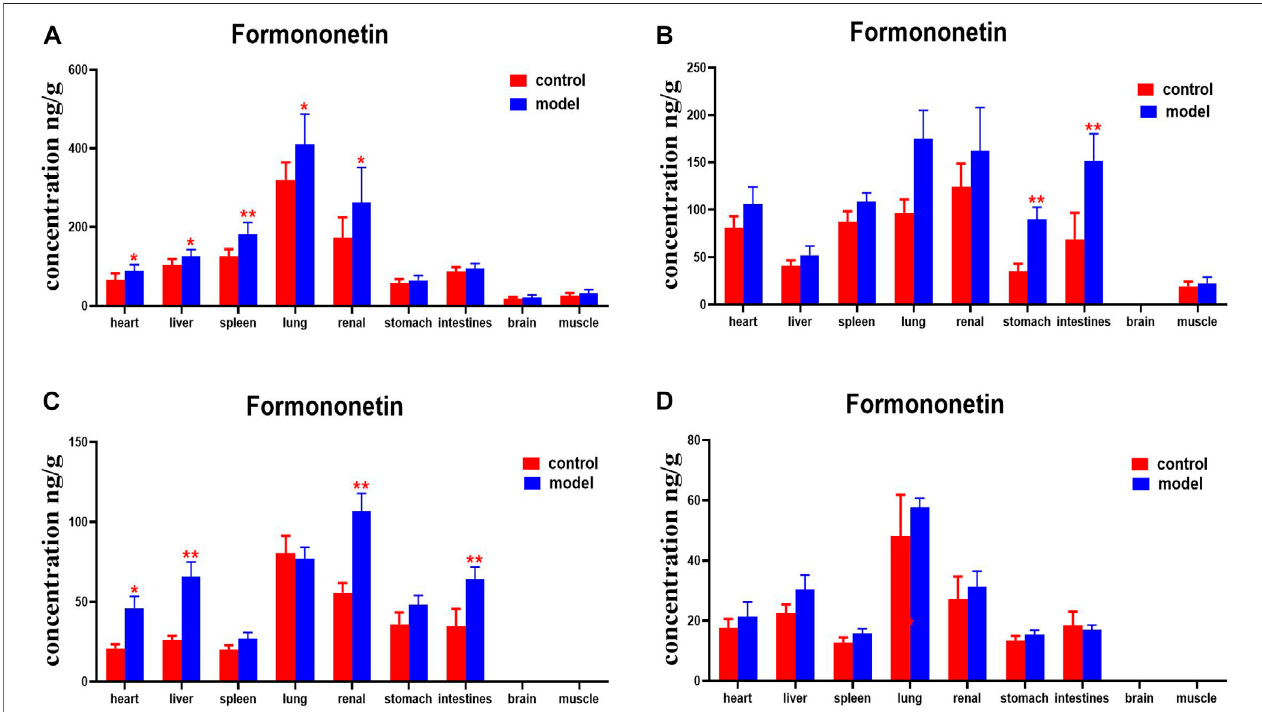
FIGURE 14 | Content of formononetin in different mouse tissue homogenate of the normal and DN models at four different time points after intragastric administration of HQD (x±SD, n =8), (A) 30 min, (B) 2 h, (C) 4 h, (D) 8 h. Ps: * P < 0.05, ** P < 0.01 vs. normal group.